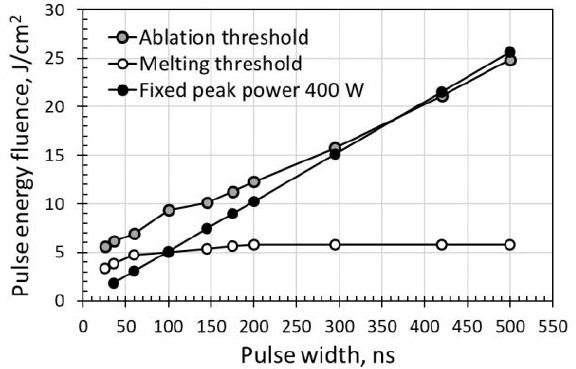
Figure 6. Variation of surface ablation and melting thresholds with pulse width.